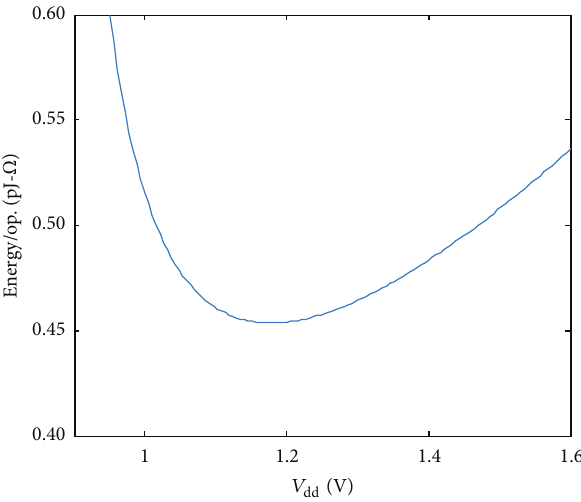
Figure 16: Optimization of switch energy per operation (constant 𝑅 ). sw